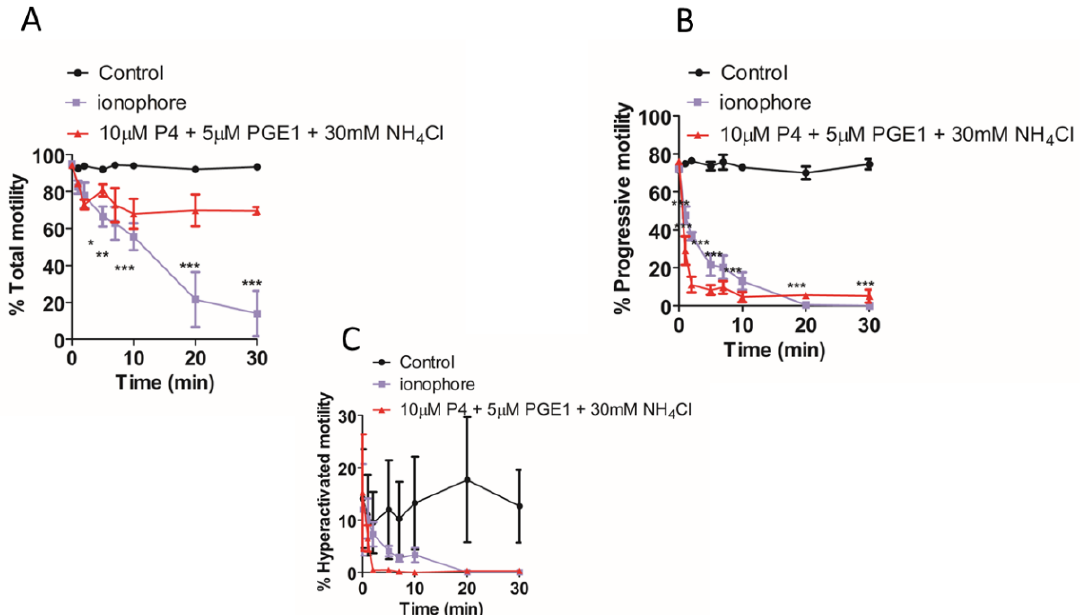
Figure 7. Simultaneous application of progesterone (P4), prostaglandin (PGE1) and NH 4 Cl impairs progressive and hyperactivated motility over 30 min exposure. ( A ). Total motility is significantly reduced ( p < 0.05) by ionophore but not P4/PGE1/NH 4 Cl (PPN). PPN and ionophore significantly ( p < 0.001) reduce progressive ( B ) and hyperactivated motility ( C ), n = 5. Data were analysed using repeated measures ANOVA followed by Tukey post-hoc test. Addition of vehicle (DMSO) served as a negative control. * p < 0.05; ** p < 0.01, *** p < 0.001.